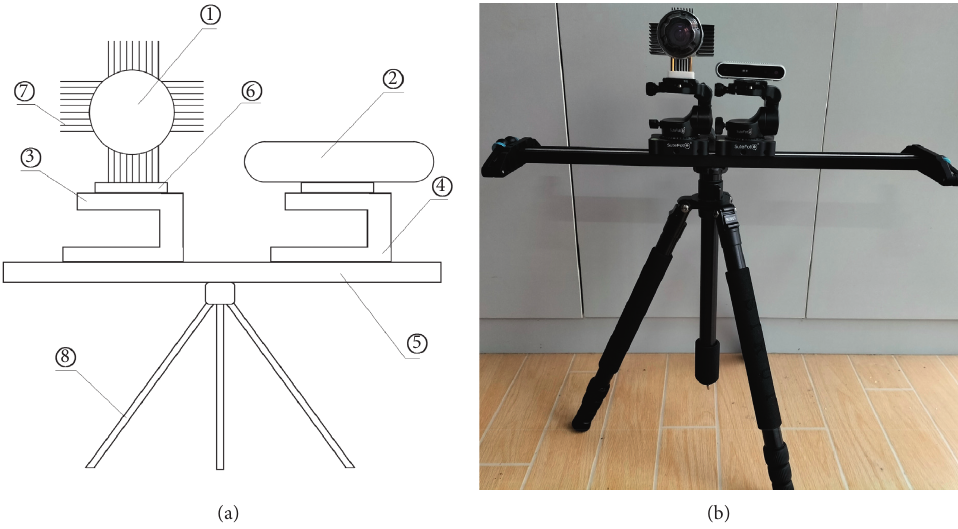
Figure 1: The hardware system. (a) The structure diagram. (b) The physical